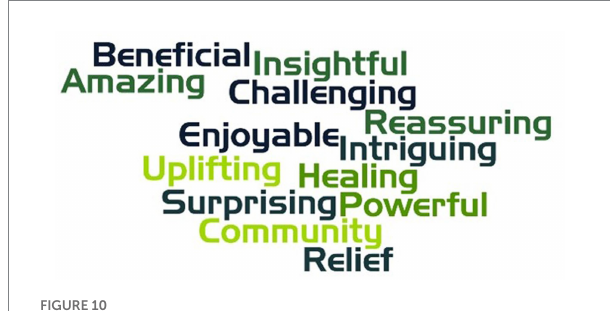
FIGURE 10 Primary themes related to the qualitative feedback received from research participants post T5 (6-mth FU/end of